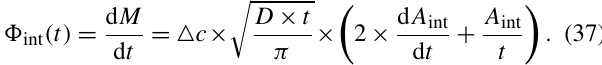
Figure 6. Conceptualization of the quantitative validation (Case 5), with locations of the salinity and temperature interfaces at a certain time after the start of a central inflow. The inflow is colder and more saline than the overlying water